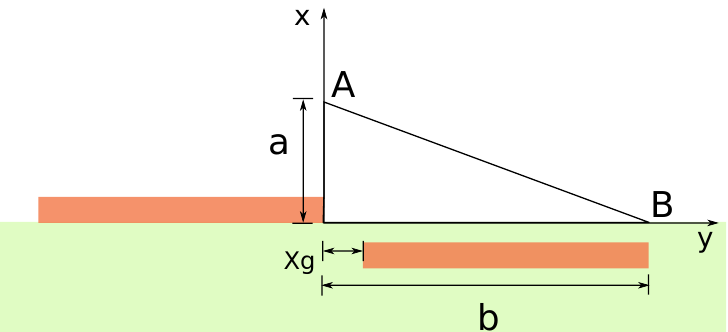
Figure 2. Linear distribution of the electric field in Shyy’s model, where a denotes the height and b denotes the length of the electric